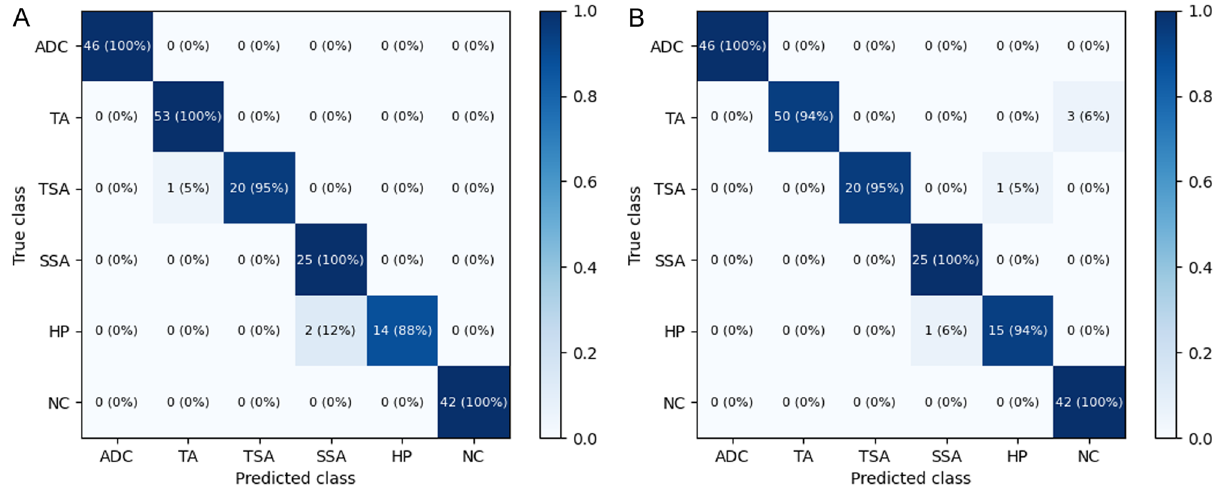
Figure 1. Heatmap of confusion matrix for the best-performing models: ( A ) DenseNet-161 ( B ) EfficientNet-B7.